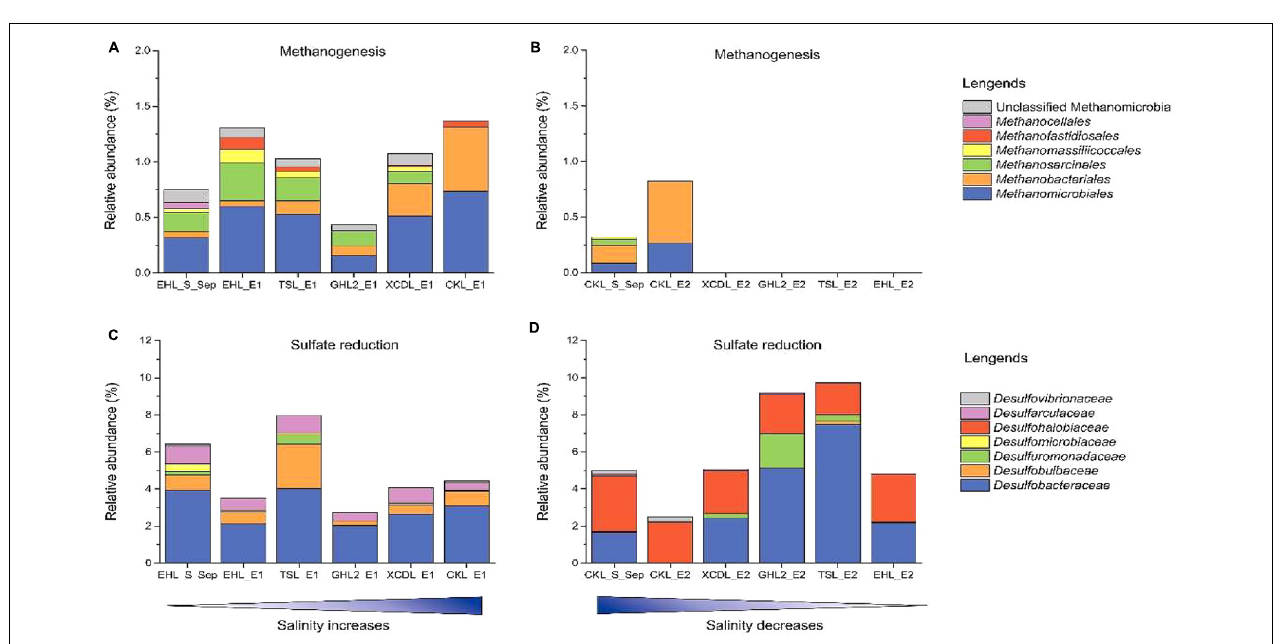
FIGURE 6 | The relative abundance variation of the identified dominant taxa (at the phylum and class levels) for experiment 1 ( A : simulating salinization) and experiment 2 ( B : simulating desalinization).